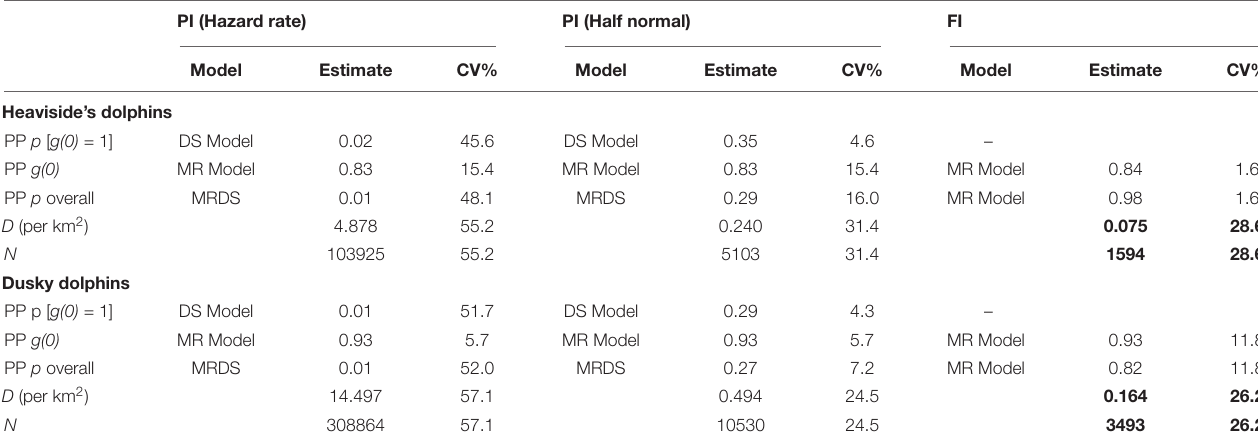
TABLE 6 | Probabilities of detection obtained from the distance sampling (DS) and mark-recapture (MR) models. PI (Hazard rate) PI (Half